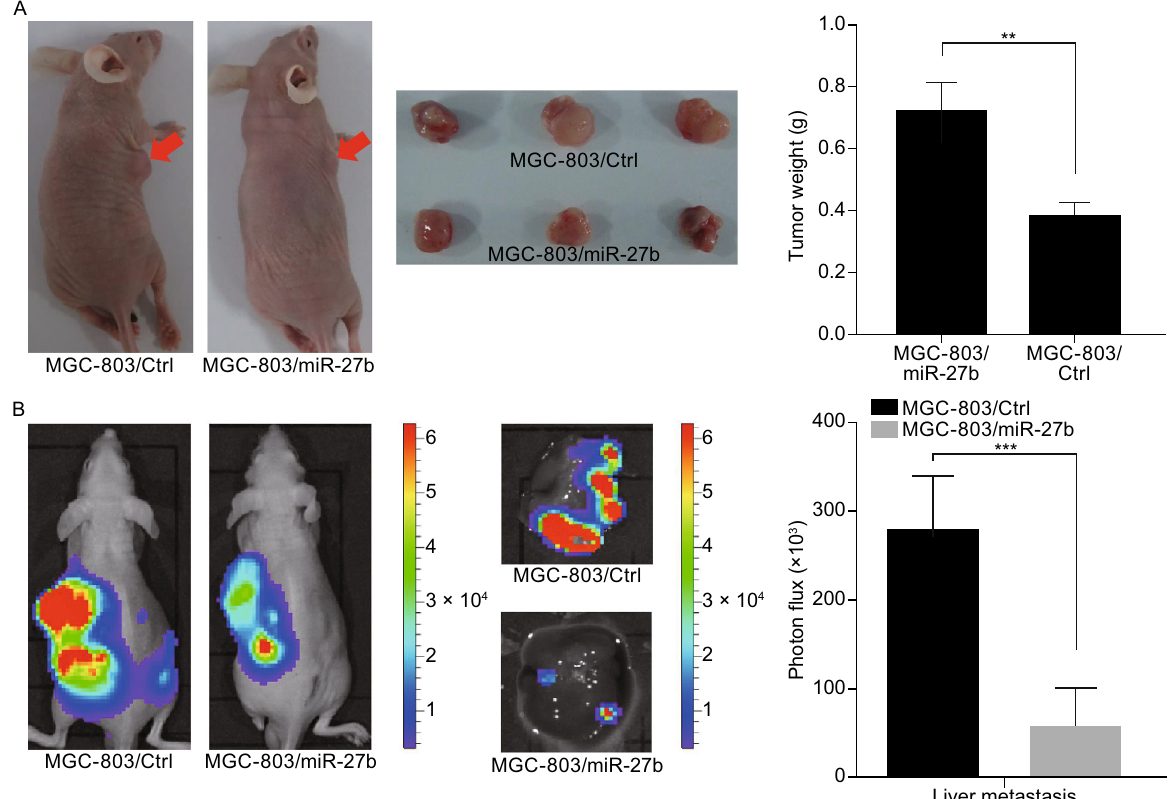
Figure 5. miR-27b suppresses tumor growth and liver metastasis of gastric cancer cells in vivo . (A) Representative images of primary tumors in the nude mice orthotopically injected with MGC-803/miR-27b or MGC-803/ctrl cells in the leg (left). Quanti fi cation of tumors in each group is shown (right). (B) Representative bioluminescence images of mice injected with MGC-803/miR-27b or MGC- 803/ctrl cells into spleen to show liver metastases (left). Quanti fi cation of liver metastases was analyzed by bioluminescence measurement (right). Scale bars, 100 μ m. * P < 0.05, ** P < 0.01, *** P <